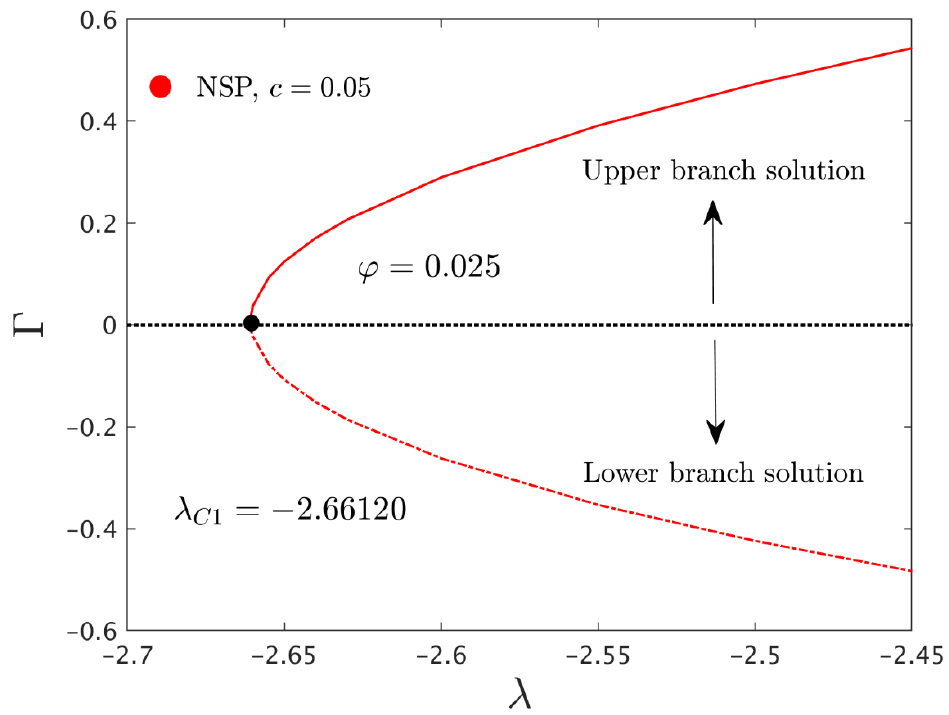
Figure 10. The graph for the Γ versus λ.